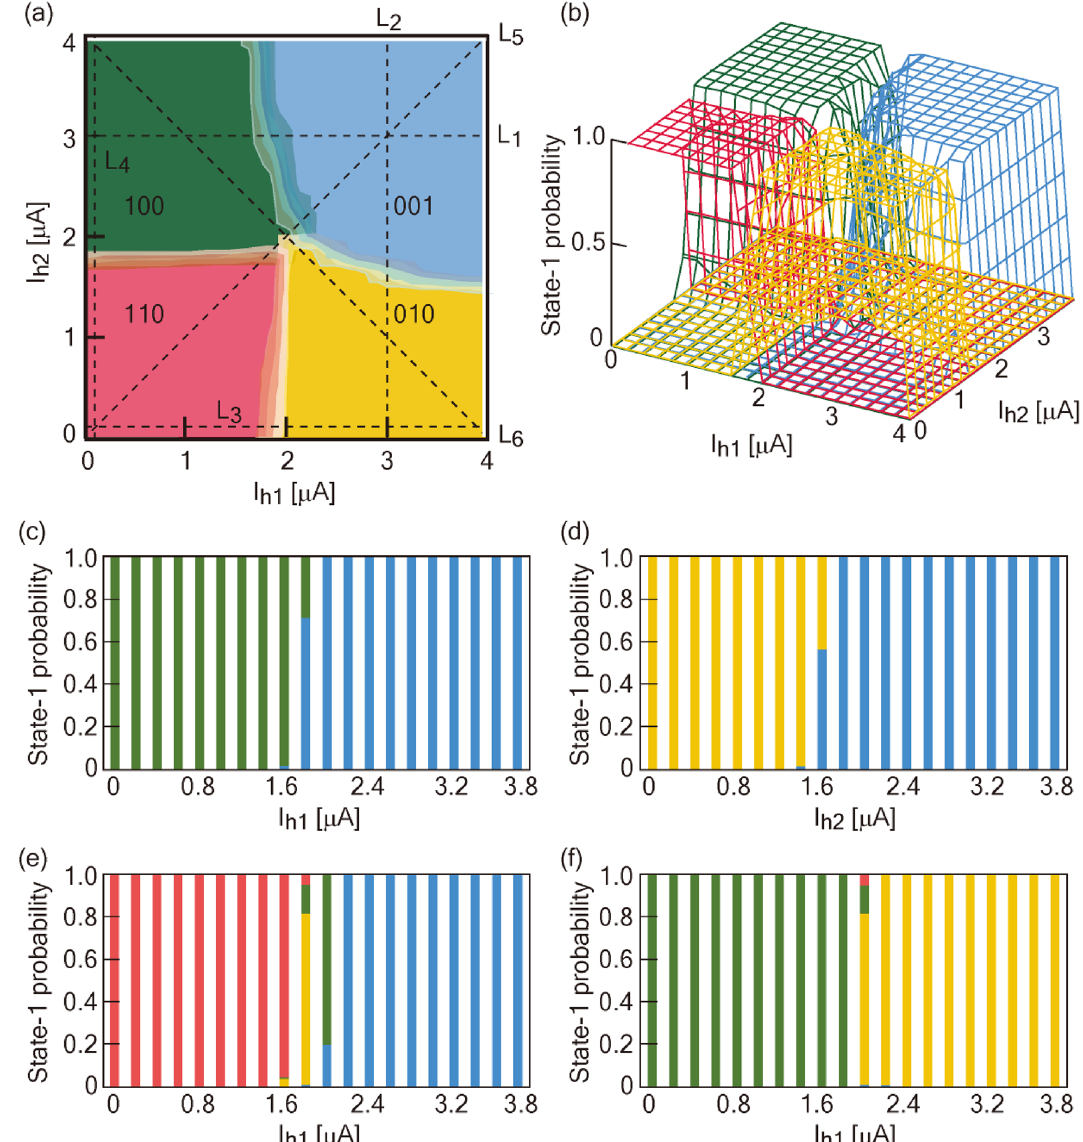
Figure 2. | Analysis of state diagrams in NOR operation. ( a ) Two and ( b ) three-dimensional state diagrams of NOR2 in a 10 mK experiment at I h3 = 2.8 µA. In order to analyze the boundary width between two logic regions (defined as a gray zone), line profiles of L 1 -L 6 , depicted in ( a ), are evaluated. Line profiles of (c) L 1 , ( d ) L 2 , ( e ) L 5 , and ( f )